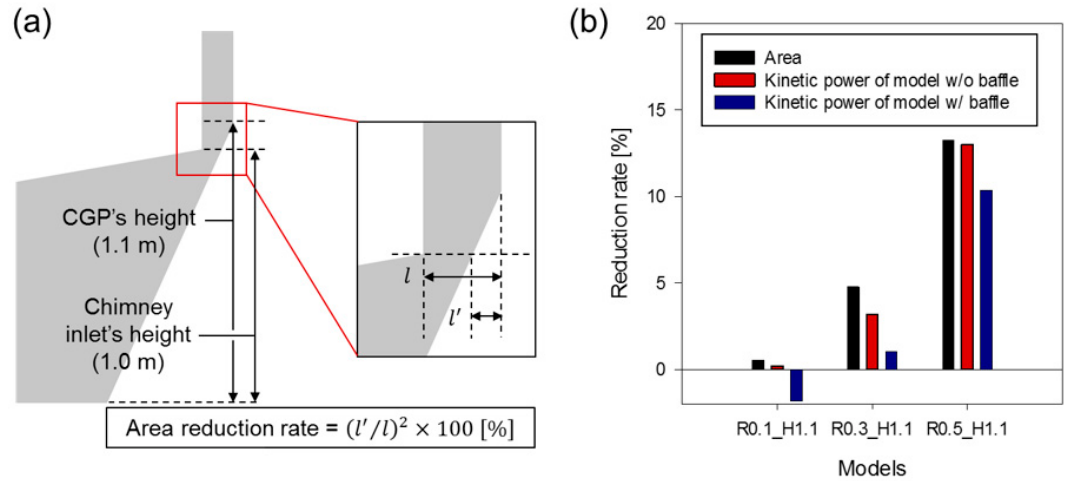
Figure 7. Area reduction by the CGP. ( a ) Schematic diagram defining the reduction in the cross-section area as a function of CGP geometry. ( b ) Area reduction rate and kinetic power for models with a height of 1.1 m.